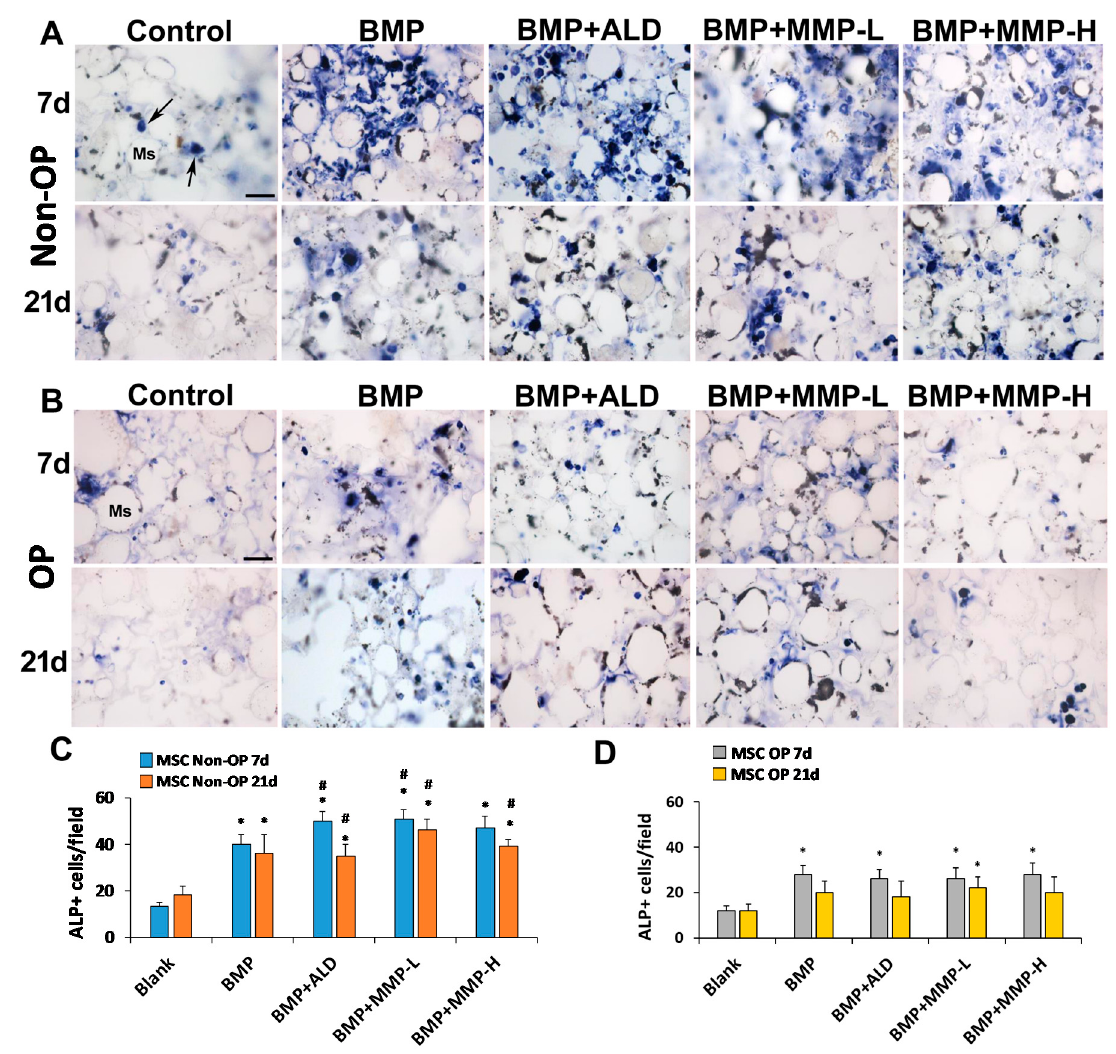
Figure 6. Panels ( A , B ) show representative images of mesenchymal stem cells from non-OP ( A ) and OP ( B ) animals cultured for 7 and 21 days and revealed for alkaline phosphatase activity. Histograms in ( C , D ) show the mean number of ALP positive cells per field at 400× magnification in non-OP and OP animals, respectively. The arrows in the upper left image indicate ALP-positive cells. Histograms represent mean ±SD values. (*) denotes statistical significant differences compared with control treatment at the corresponding time point. (#) denotes statistical significant differences compared with BMP treatment at the corresponding time point. Ms: microspheres. Scale bar = 30 µm.